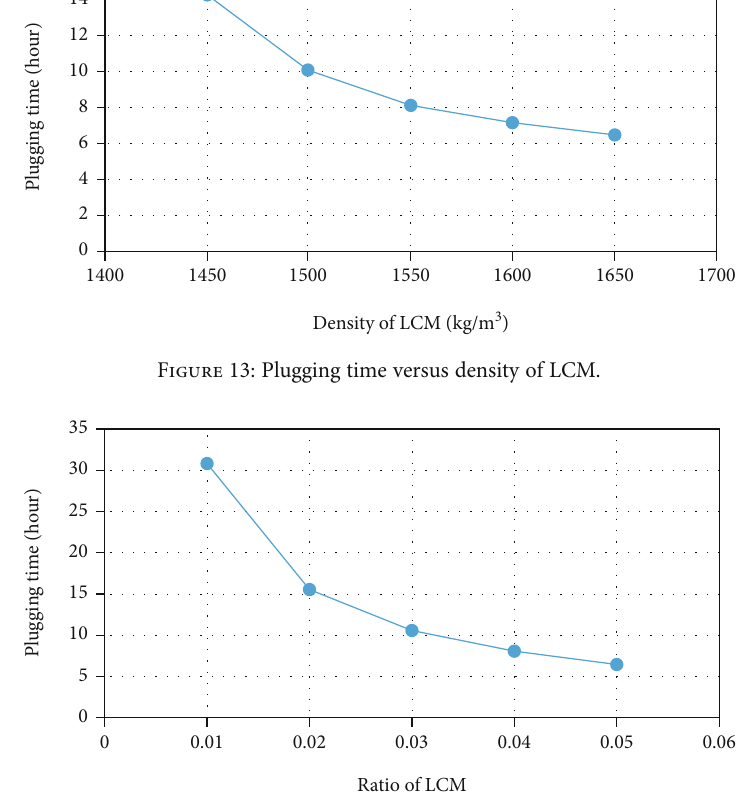
Figure 14: Plugging time versus ratio of LCM to fl